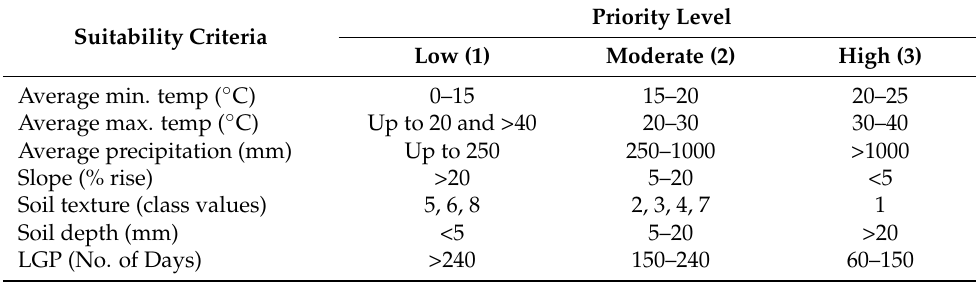
Table 1. Priority levels for thematic